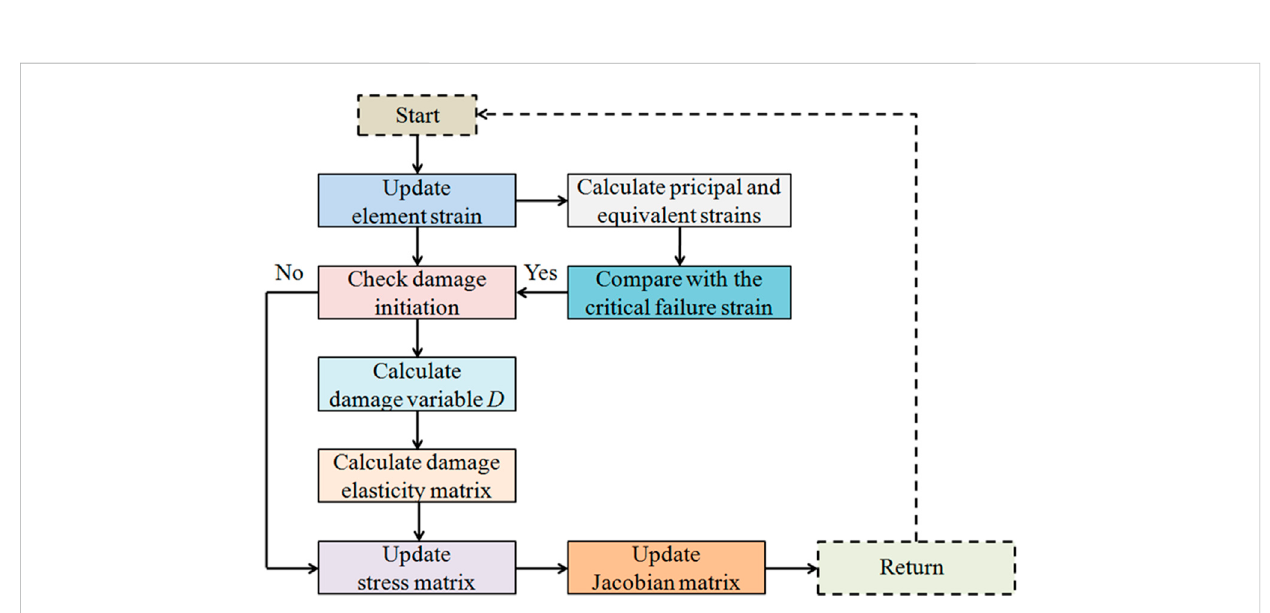
Detailed fl ow chart for simulating the progressive failure in the cortical bone structure using